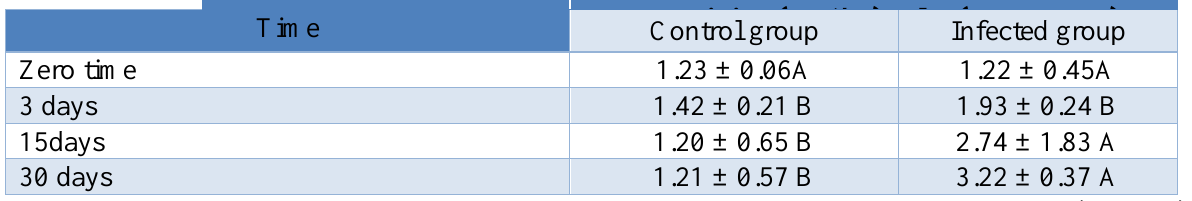
Table, 5: Effect of E.coli infection on creatinine value of infected group compared with control group at zero time, 3,15 and 30 days post